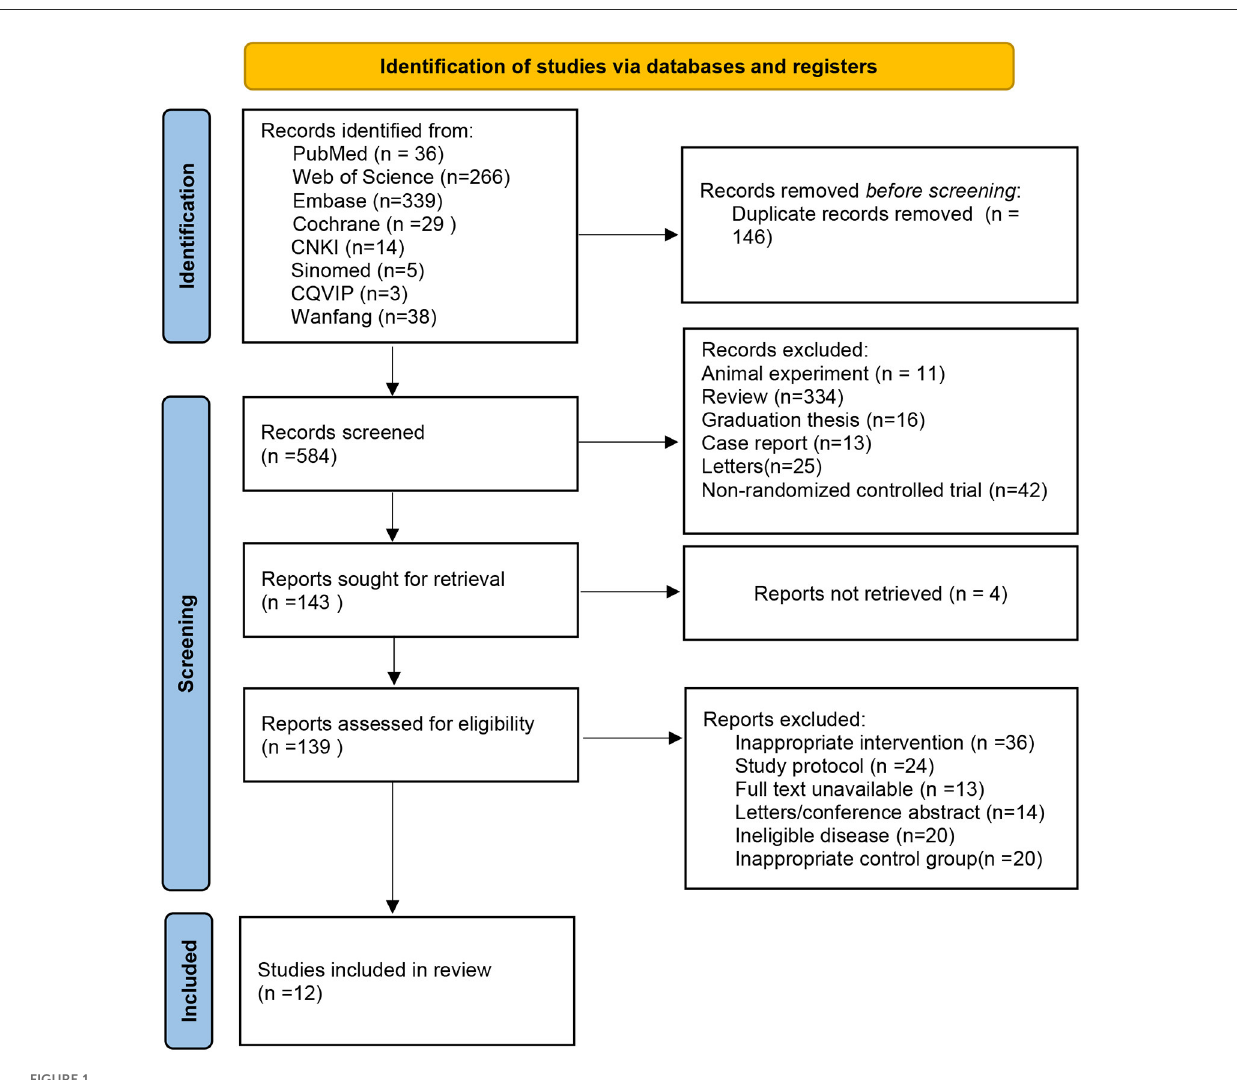
FIGURE1 Literature screening flowchart and